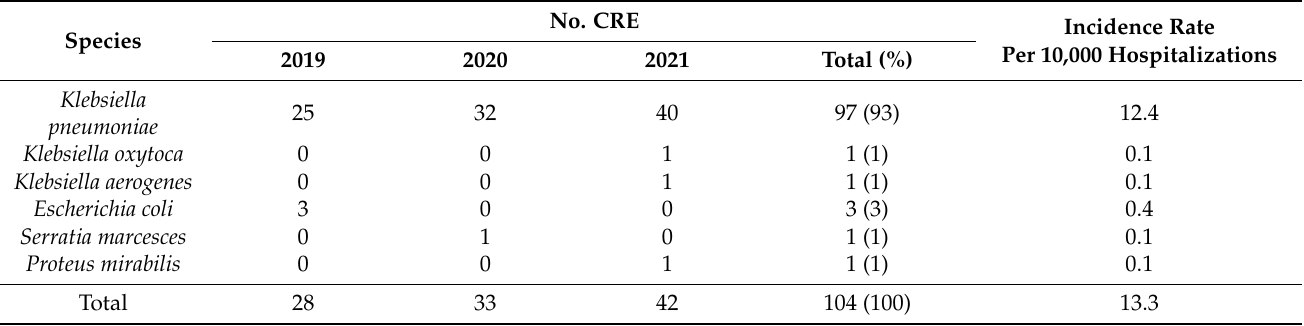
Table 3. Species distribution among CRE from HAI.